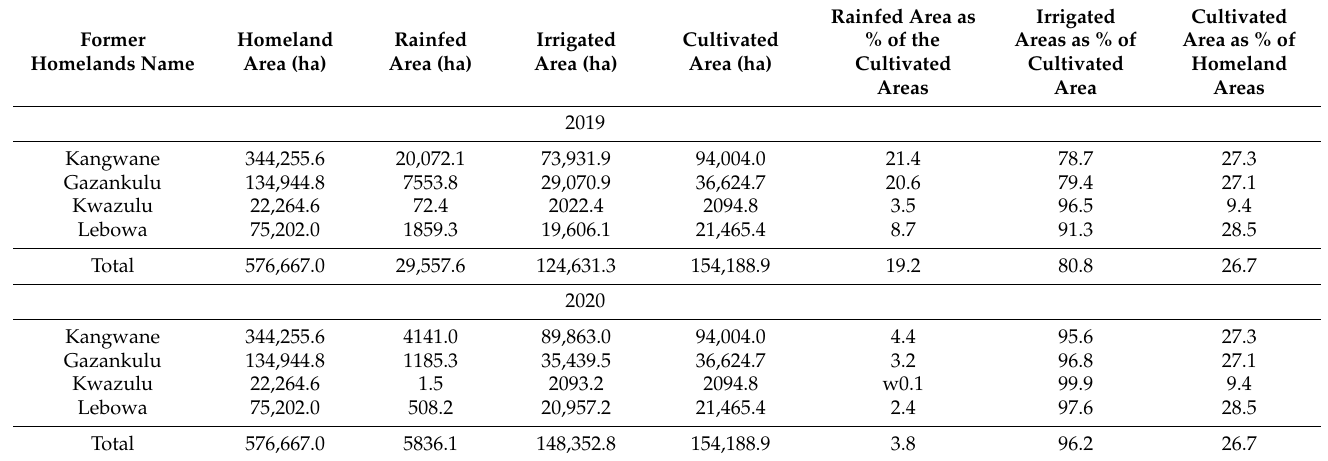
Table 4. Proportions of irrigated and rainfed areas in former homelands in 2019 and 2020.